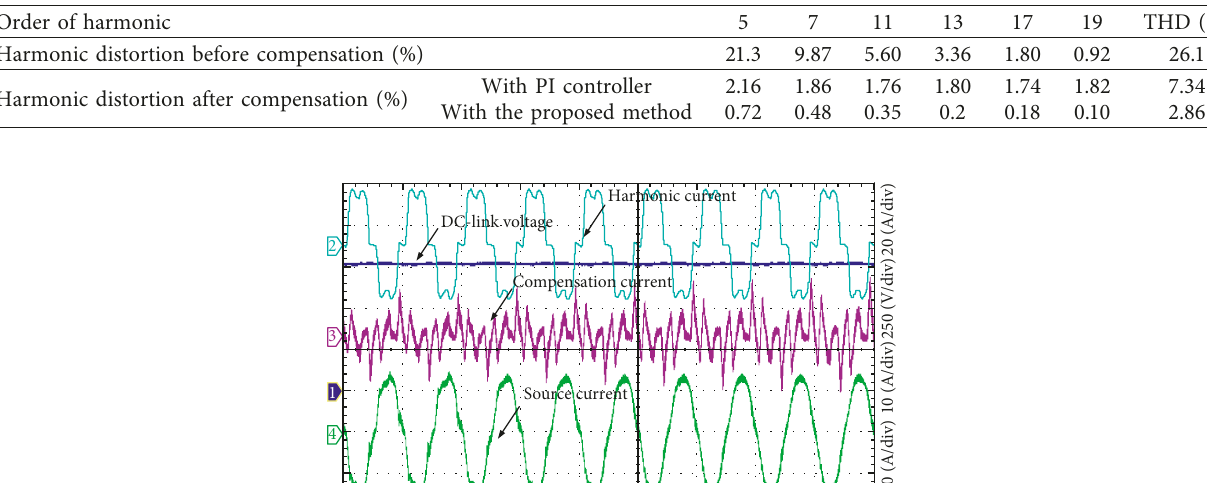
Figure 22: Experimental steady waves for proposed scheme. Table 2: Compensation results with two control algorithms.